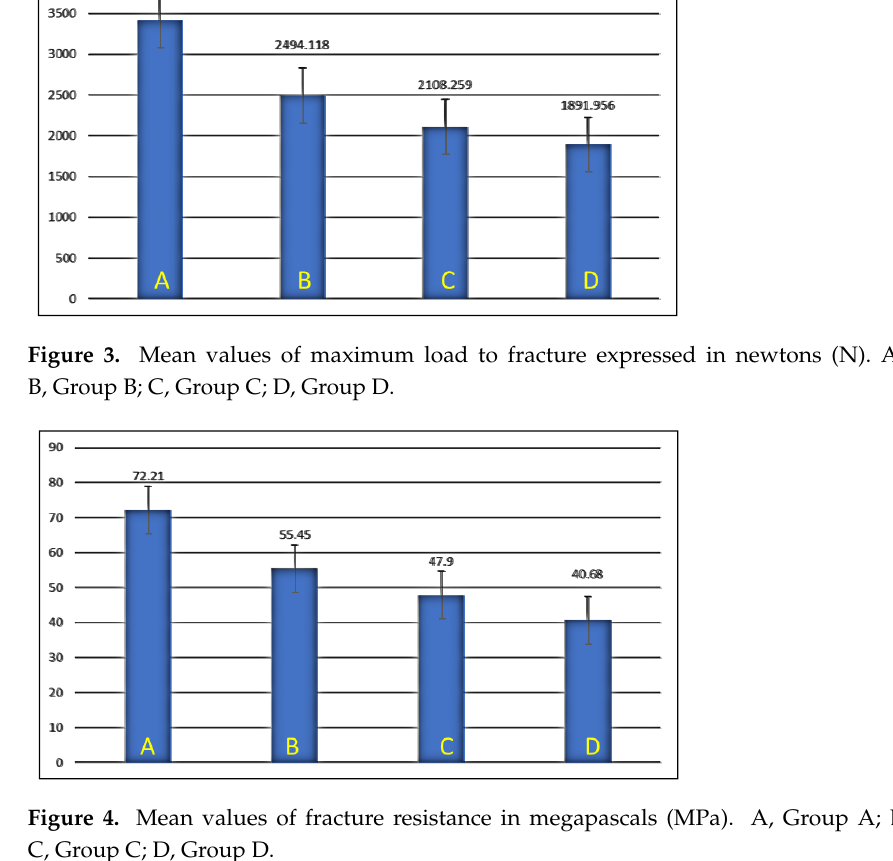
Table 3. Dependance of variable; Tukey HSD intergroup comparison.